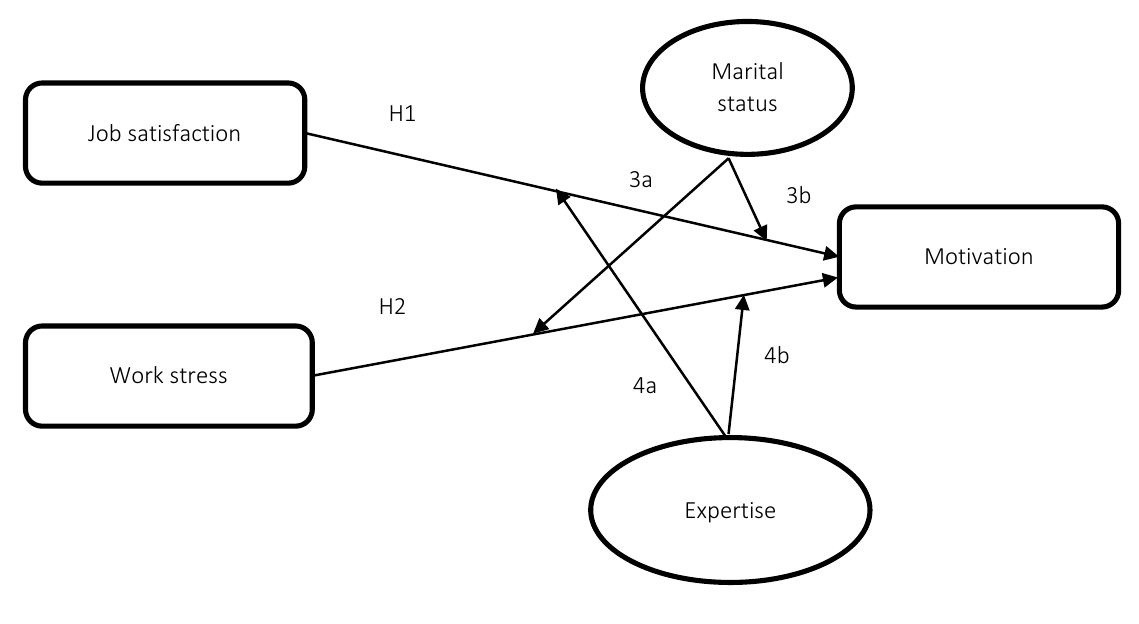
Figure 1. Hypothetical